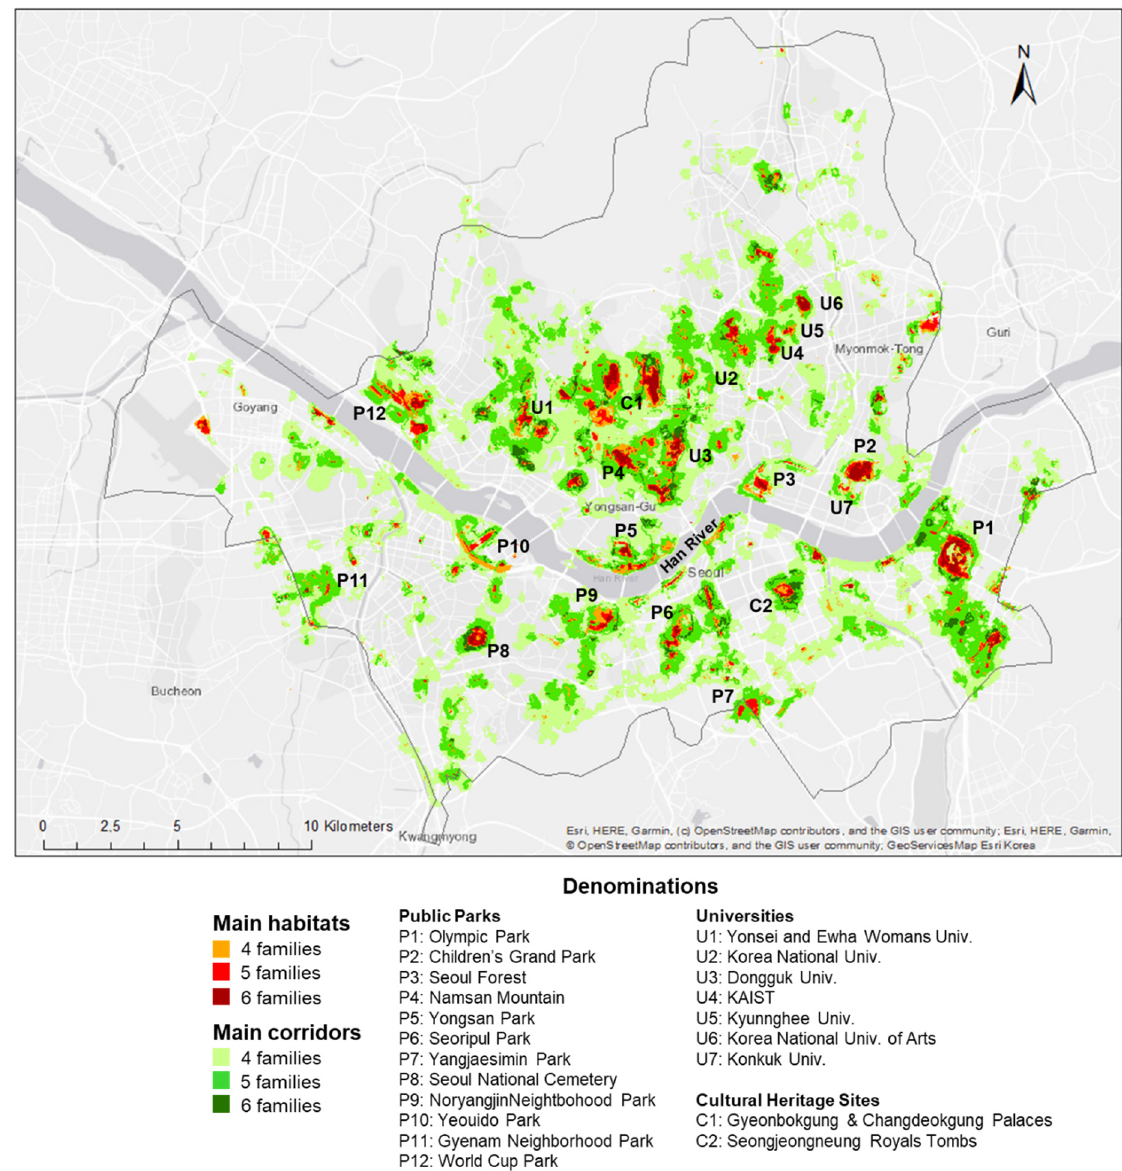
Figure 5. Map illustrating the main habitats and corridors for six families of pollinators in Seoul city. The main public parks, universities, and Cultural Heritage Sites are representing most of the largest main habitats.